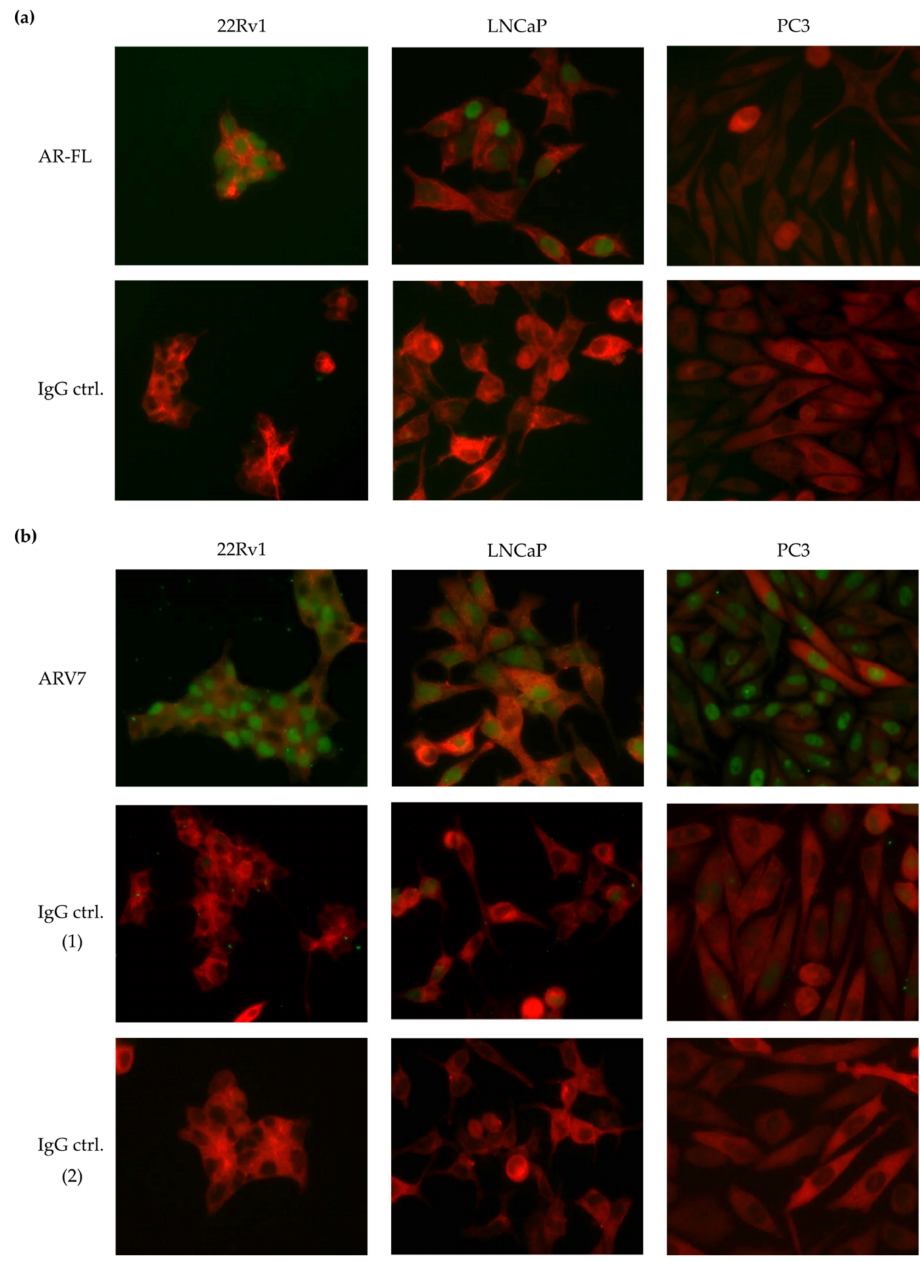
Figure 1. Immunocytochemical (ICC) staining of full-length androgen receptor (AR-FL) and ARV7 on three selected prostate cancer cell lines. Cells are stained for pan-keratin in red (anti-PanCK, CellSearch ® , Menarini) in all images. ( a ) Upper panel: ICC staining performed using the anti-AR-FL antibody (7395S Ozyme) in green. AR-FL positive cells lines 22Rv1 and LNCaP show positive nuclear AR-FL staining, while PC3 cells remain unstained. Lower panel: ICC control staining using Rabbit [DA1E] IgG XP isotype (2975S Ozyme) in green showing the absence of unspecific staining on 22RV1, LNCaP and PC3 cells. ( b ) Upper panel: ICC staining performed using the anti-ARV7 antibody [EPR15656] (209491 Abcam) detected by a FITC-conjugated secondary antibody. A positive nuclear staining is observable on all three cell lines (in green), indicating unspecific signal of the antibody in PC3. Medium panel: ICC staining performed with the Rabbit IgG, monoclonal [EPR25A]-Isotype Control (172730 Abcam) detected with FITC-conjugated secondary antibody (97050, Abcam) showing negativity on 22RV1, LNCaP, and PC3 cells. Lower panel: ICC staining performed with FITC-conjugated secondary antibody (97050, Abcam) showing negativity on 22RV1, LNCAP, and PC3